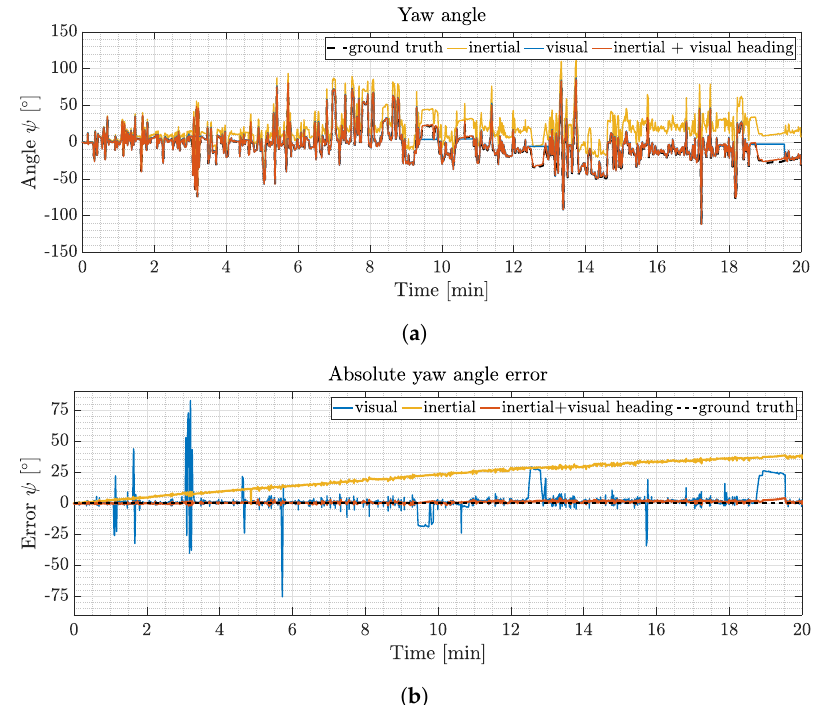
Figure 9. Yaw angle estimations and the corresponding absolute error for one trial: ( a ) yaw angle comparisons between ground truth (Qualisys, black), inertial only orientation estimation (yellow), visual SLAM orientation estimation only (blue) and the proposed orientation estimation with visual heading vector substitute (orange). Figure ( b ) depicts the corresponding heading error referenced to the Qualisys system for either visual only (blue), inertial only (yellow) or visual and inertial yaw angle estimations (orange).